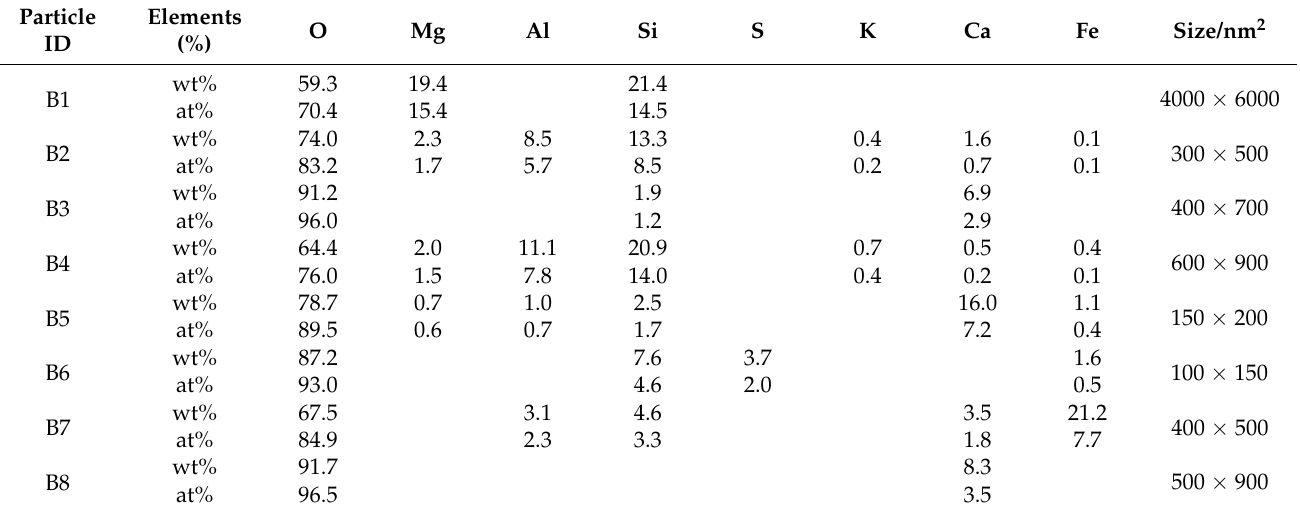
Table 4. The EDS data of particles and aggregations in background samples (IDB1-B3,ascending gas flow, IDB4-8,